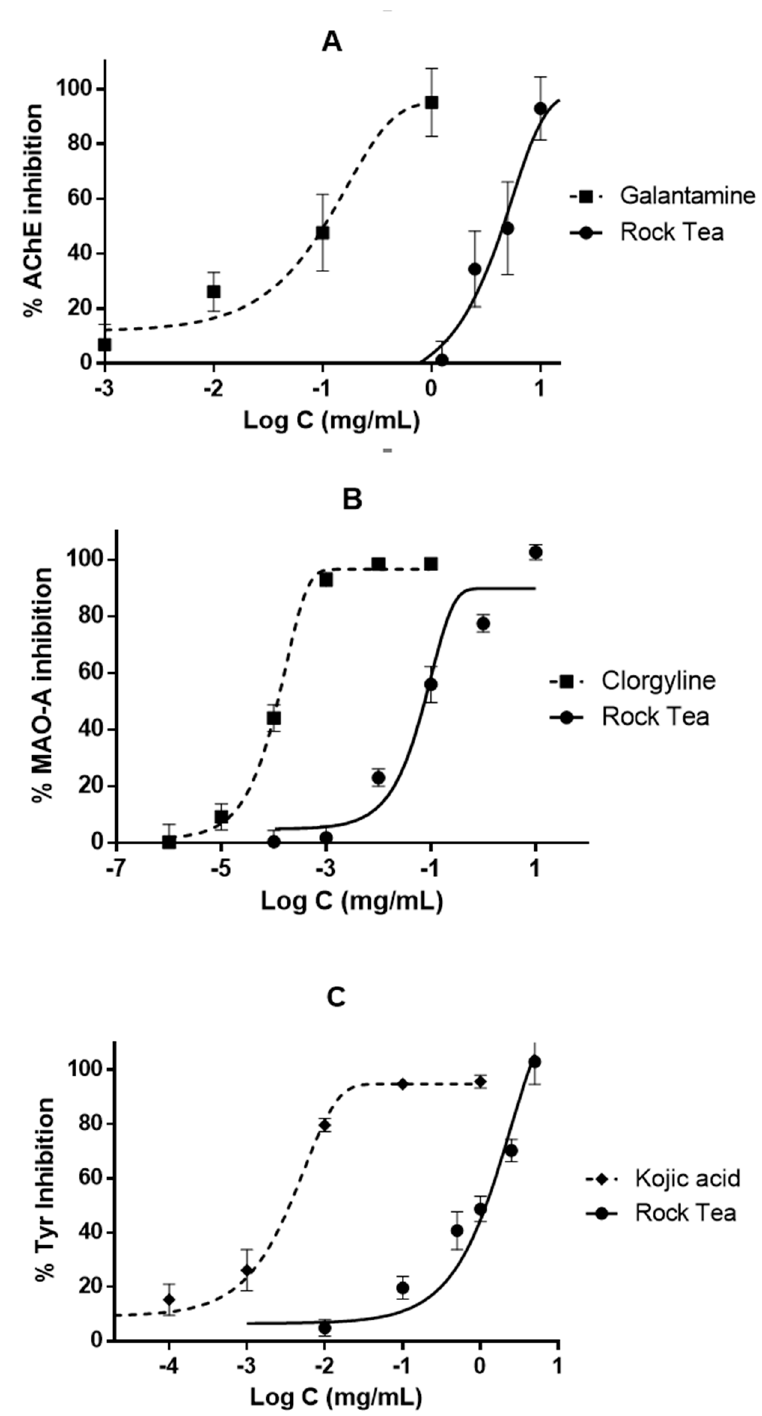
Figure 5. Neuroprotective effect of RT extract on nervous system enzymes; ( A ) Acetylcholinesterase (AChE) inhibition, ( B ) Monoamine oxidase A (MAO-A) and ( C ) Tyrosinase (TYR) inhibition. Galantamine, clorgyline and kojic acid have been used as reference inhibitors, respectively.